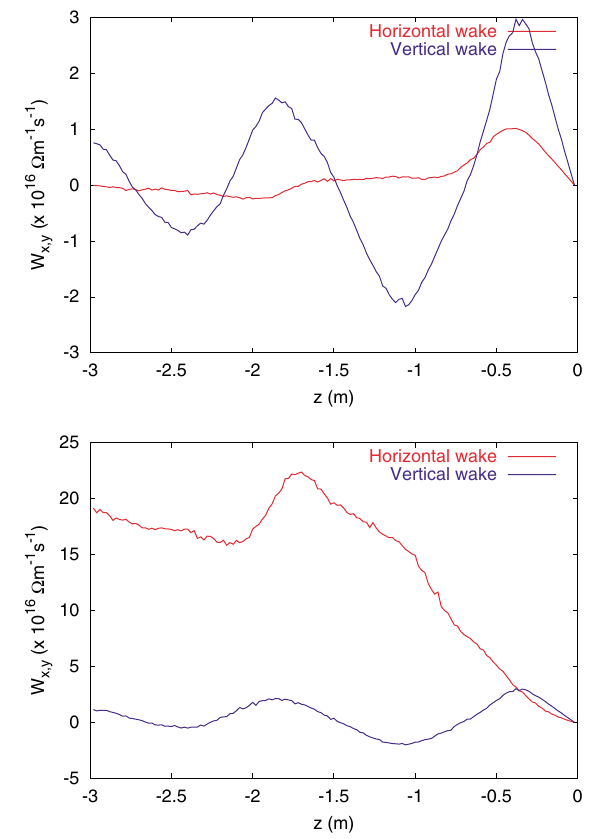
FIG. 9. (Color) Electron cloud horizontal and vertical wake functions for a longitudinally uniform bunch in a combined function magnet with magnetic field gradients of 0 : 52 T = m (upper panel) and 52 T = m (lower